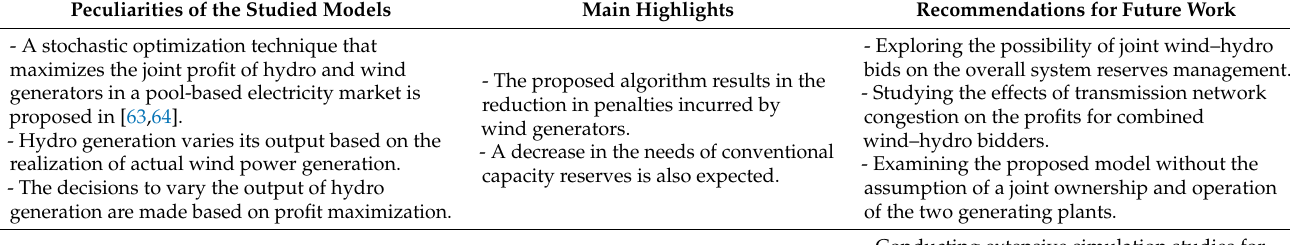
Table 1. Summary of market models proposed under the two-stage settlement mechanism. Peculiarities of the Studied Models Main Highlights Recommendations for Future